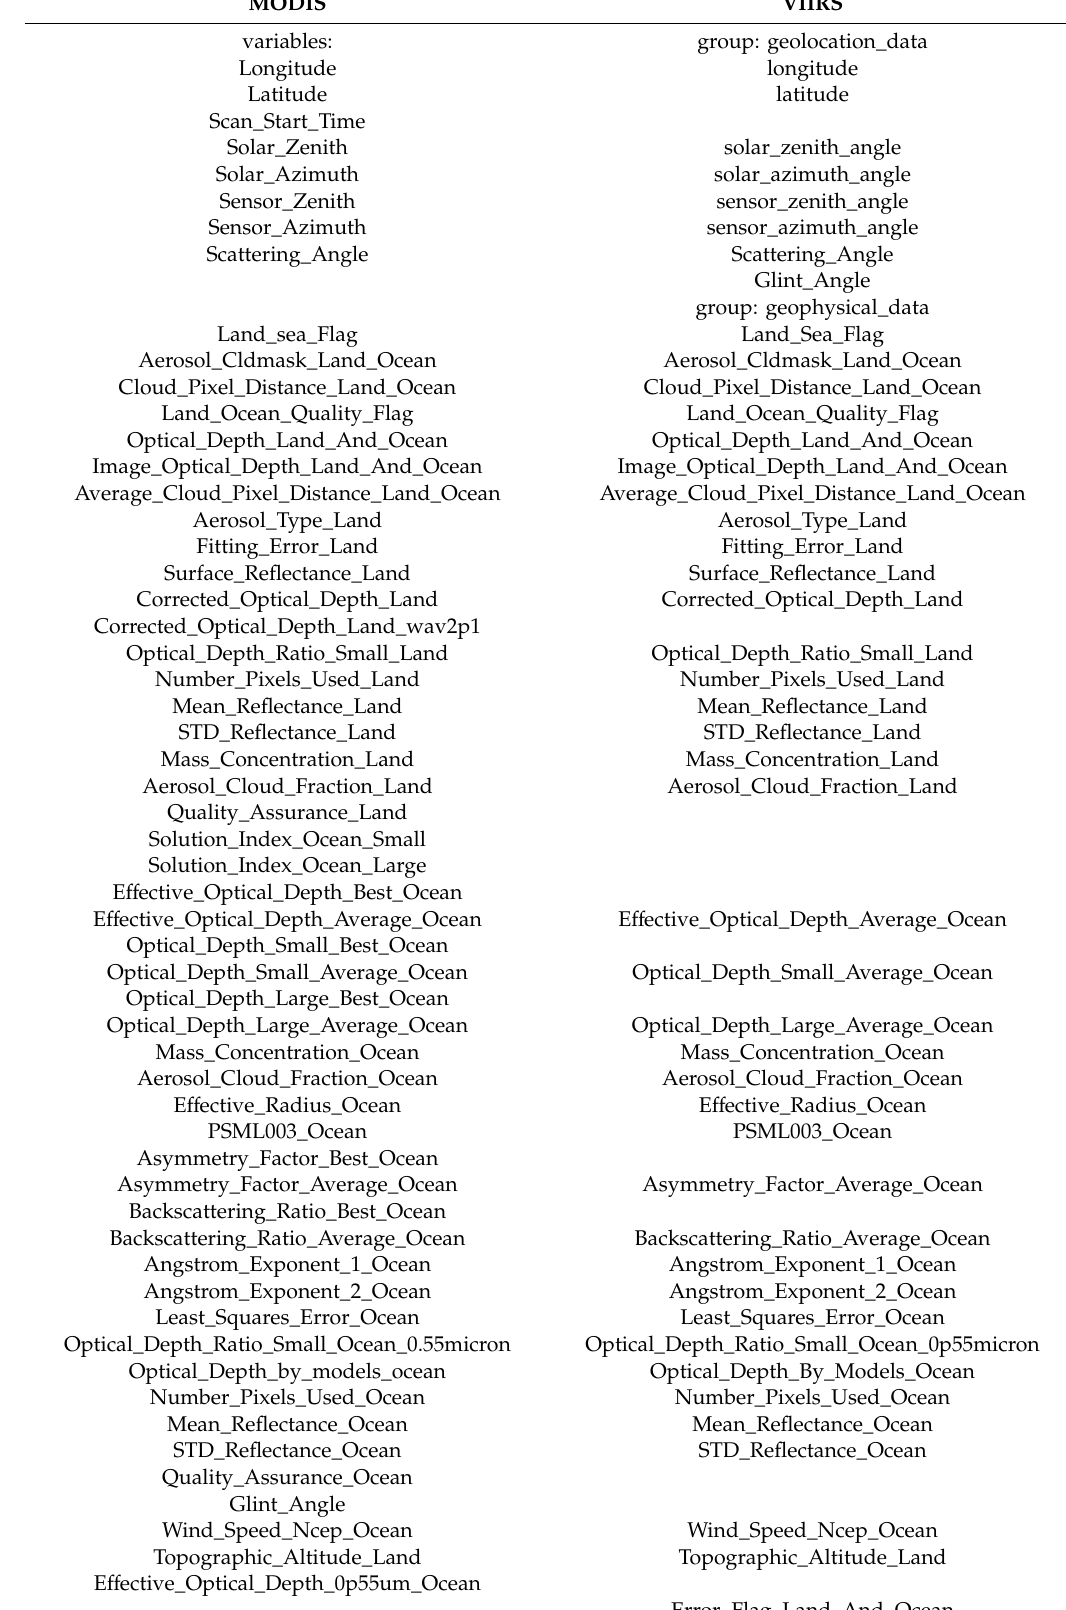
Table A1. Side by side comparison of the datasets in each Dark Target product (Deep Blue (DB) and merged DT / DB datasets for MODIS